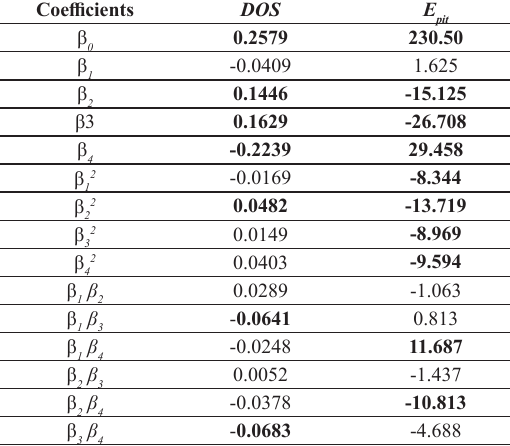
* Bold values represent the individually significant terms ( P -value<5%). Table 7. ANOVA for the models developed.